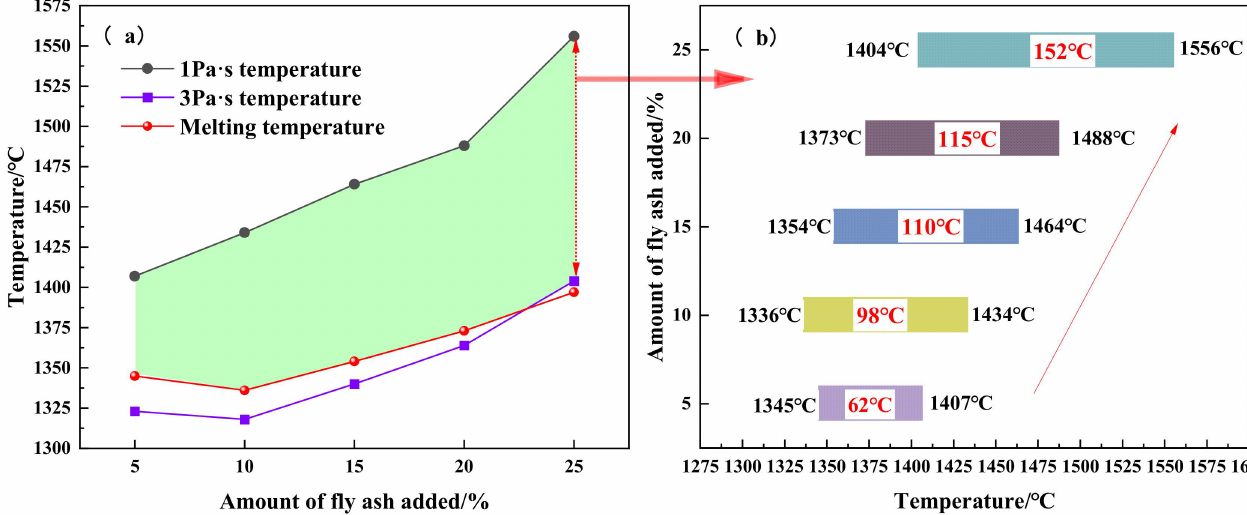
Figure 4. Changes in the suitable fiber-forming temperature range of modified blast furnace slag. ( a ) The temperature and melting temperature of modified blast furnace slag with different fly ash additions. ( b ) The suitable fiber-forming temperature